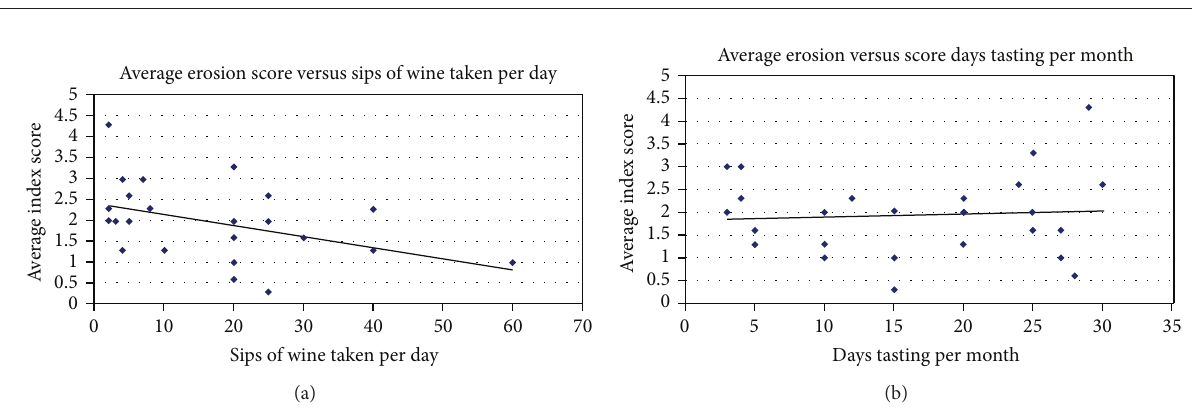
of sips per wine tasting day was only 18 sips, and the median number of sips was 20 per day. The highest number of sips was 60 and the lowest was 2 sips per tasting